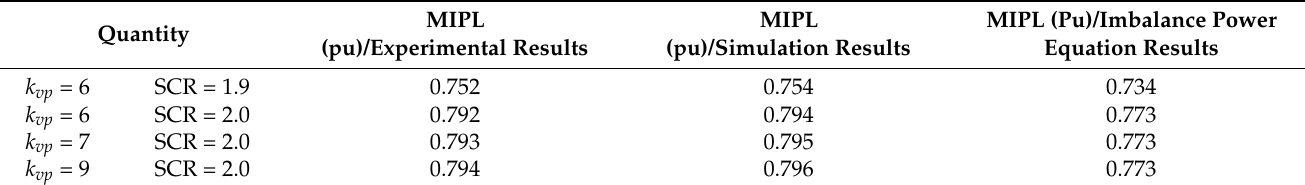
Table 3. Experimental Results, Simulation Results and the Theoretical Results.